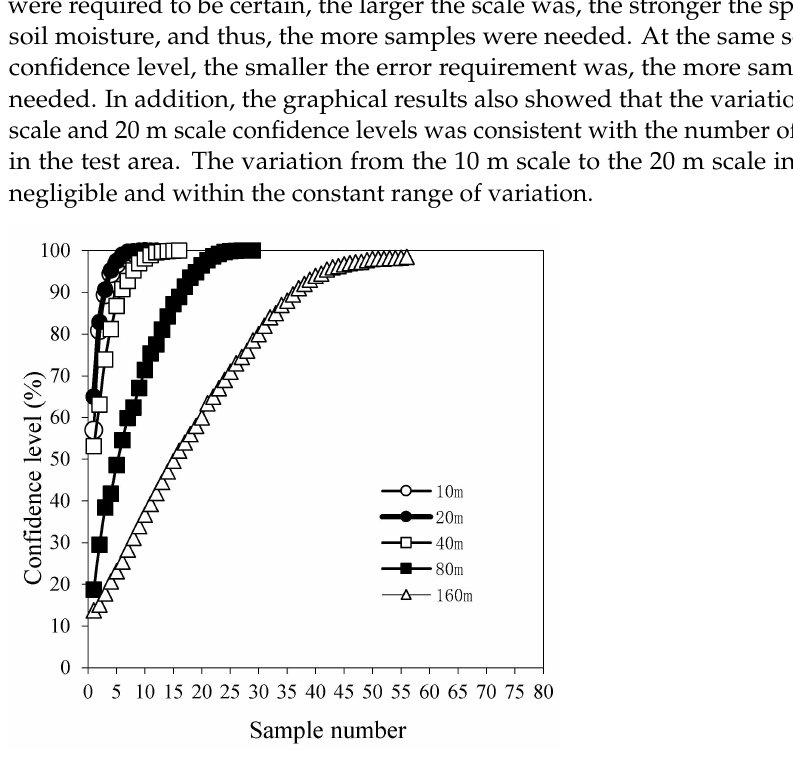
Figure 3. Relationship between the sample number and the confidence level at the 10 m, 20 m, 40 m, 80 m, and 160 m scales at a relative error of